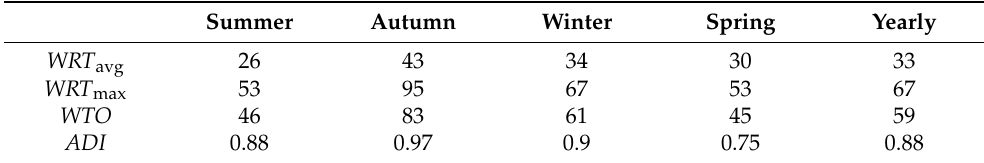
Table 5. Summary of the main quantities helpful to classify the basin flushing features, including the maximum vertically averaged water residence times ( WRT max) and the basin average ( WRT avg), the turn-over time ( WTO ) and the advection index ( ADI